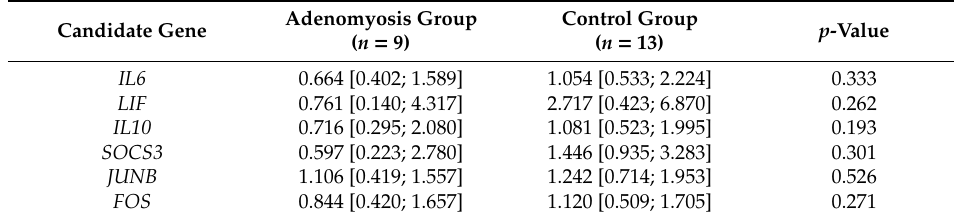
Table 5. The fold change of selected genes in study groups. Values reported as median (95% CI for